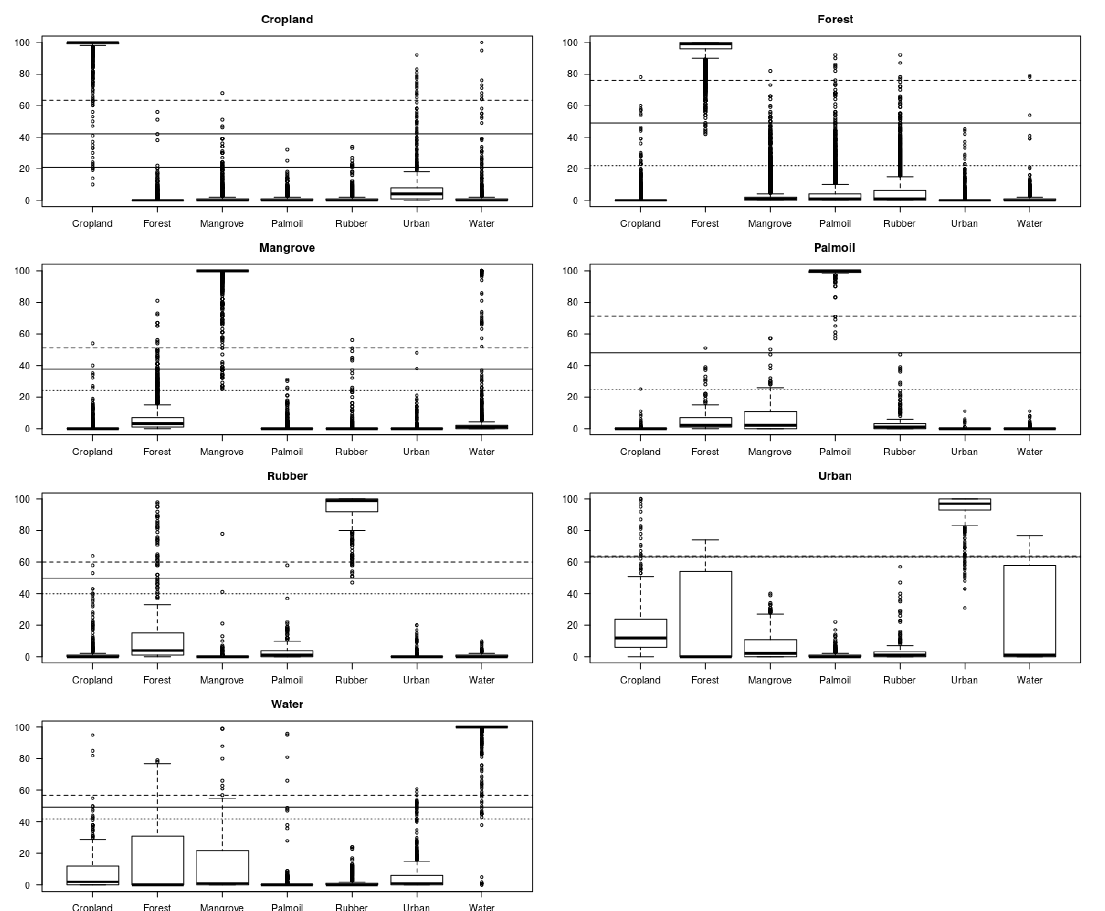
Figure 4. In the decision tree we used 2.5 and 97.5 percentiles of the primitive and all other classes respectively, indicated with a dashed line. The mean of the two was used as a threshold in the decision tree. The distance of the percentiles to the threshold was used in the Monte-Carlo